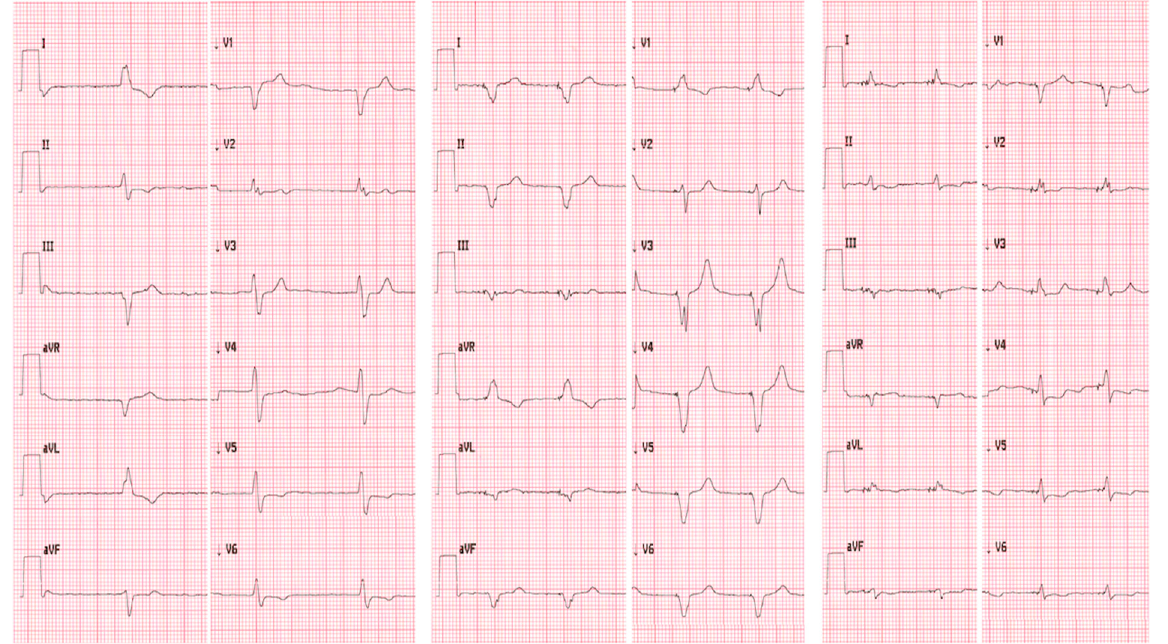
Figure 1. The 12-lead ECG of patient 1—initial QRS duration of 150 ms—on the left, BiV 140 ms—in the middle, HOT-CRT 120 ms—on the right.